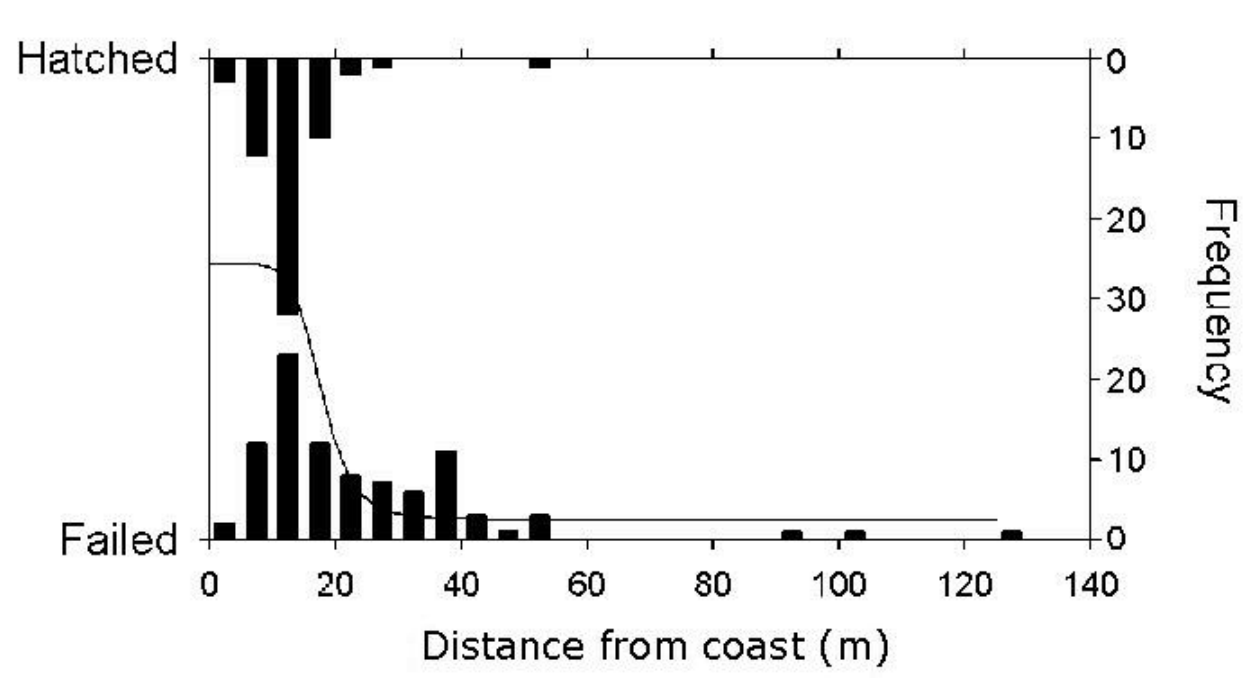
Fig. 5 . Distance from coast at laying, identified as a predictor of hatching success for 153 nests in 2003 in a multivariate logistic